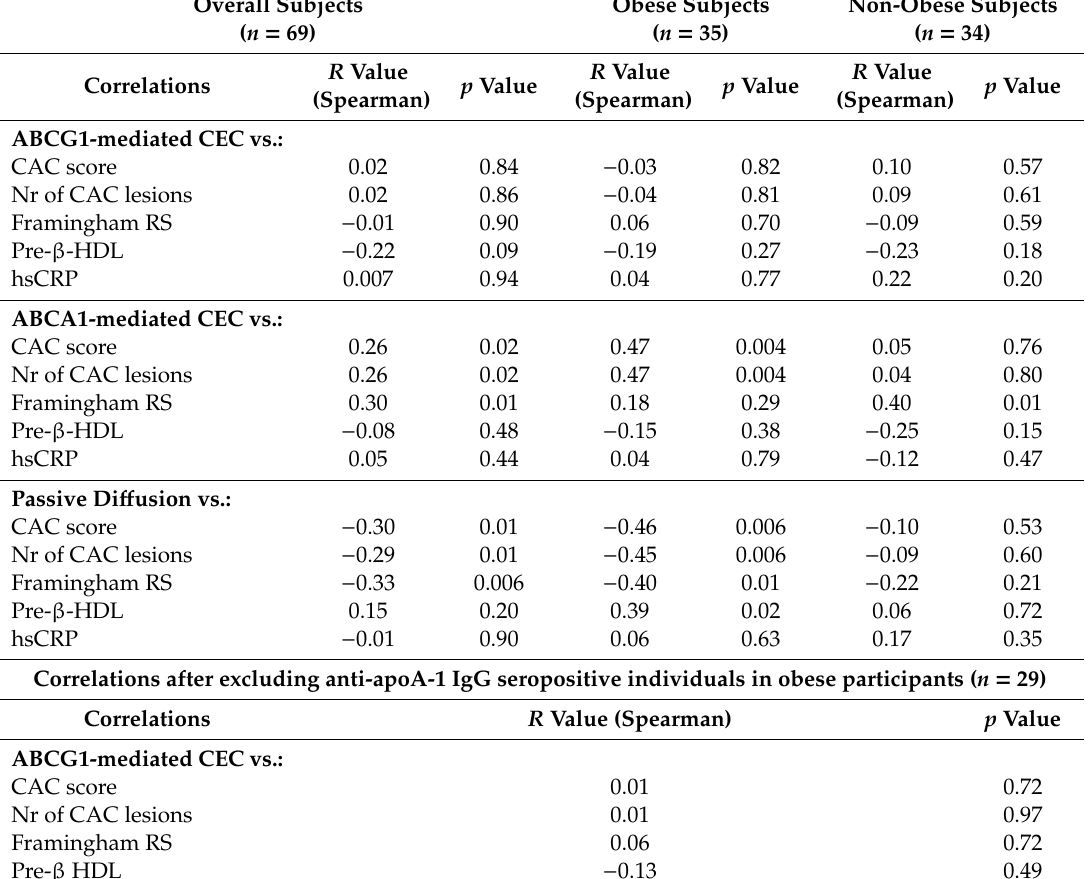
Table 2. Correlations between CEC Pathways, CAC Score, Framingham Risk Score, Pre-Beta-HDL, and hsCRP Levels.